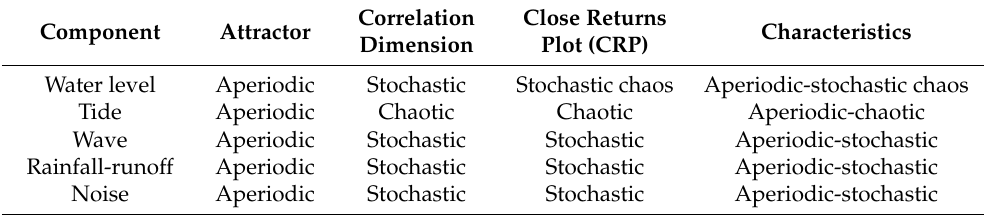
Table 4. Summary for characteristics by